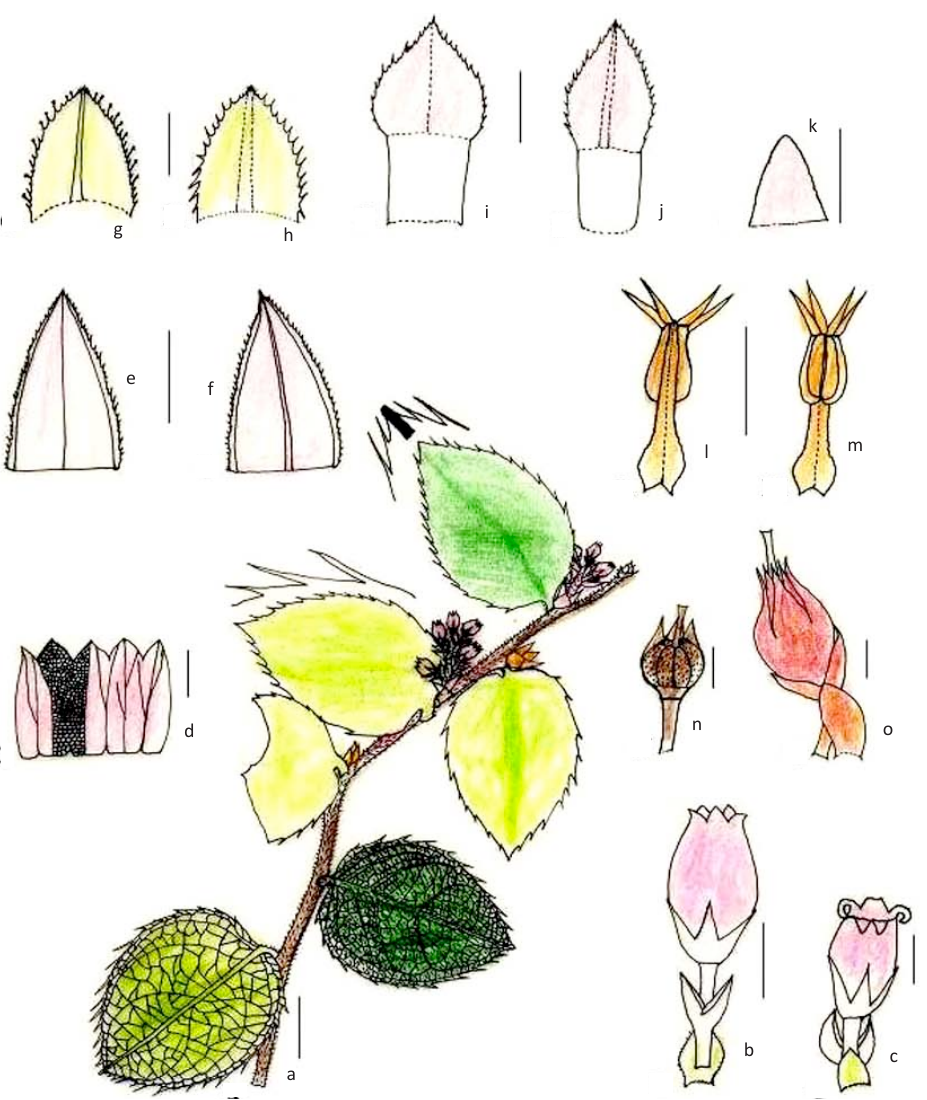
Figure 1. Gaultheria akaensis Panda & Sanjappa a - habit; b–c - flowers; d - corolla; e–f - calyx lobes; g–h - bracts; i–j - bracteoles; k - corolla apex; l–m - stamens; h - pistil; o - fruit. Scale bar: a - 1cm; b–d - 2mm; e–o - 1mm (drawn from S. Panda 30824,